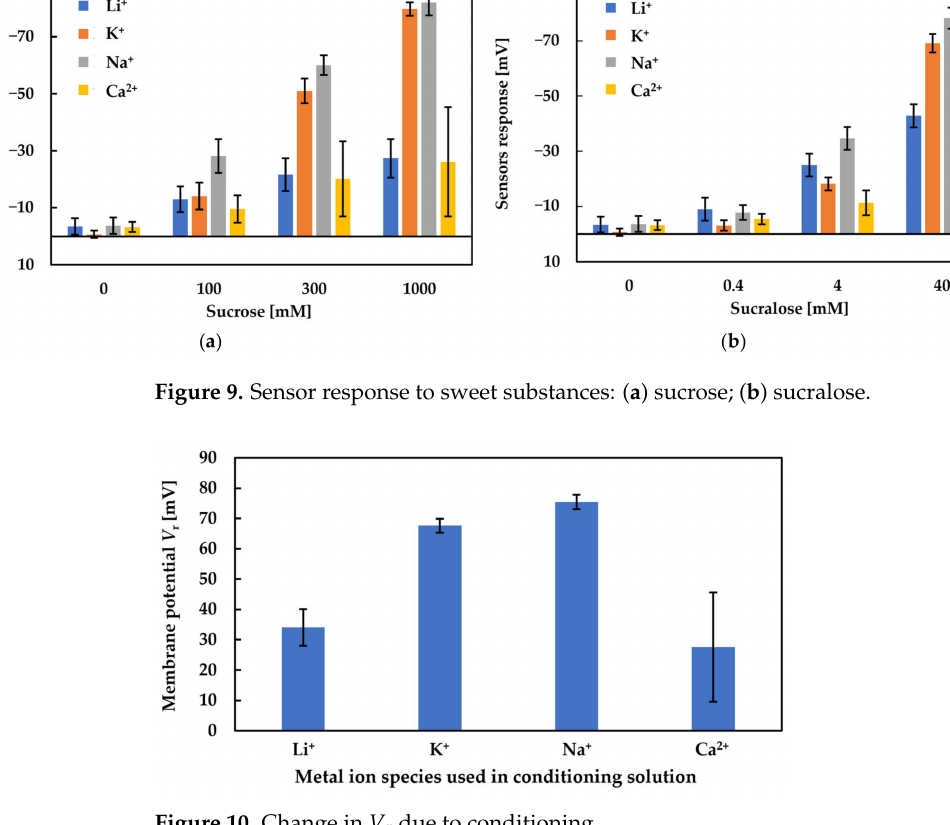
Figure 10. Change in V r due to